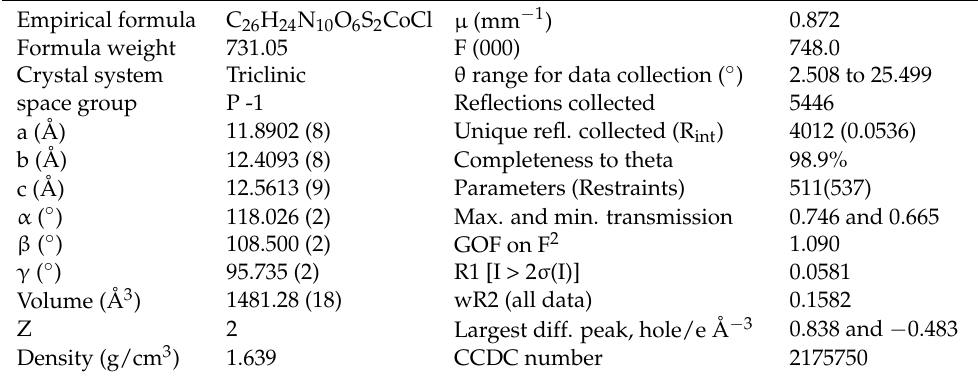
Table 1. Crystallographic data for the cobalt(III) complex C1